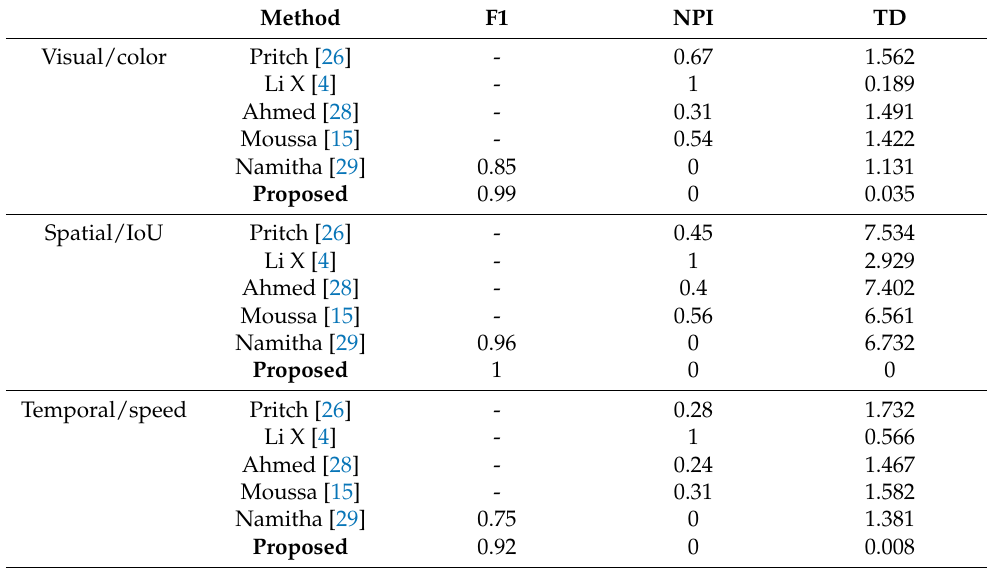
Table 5. Results of the proposed algorithm and the conventional methods in terms of F1, NPI and